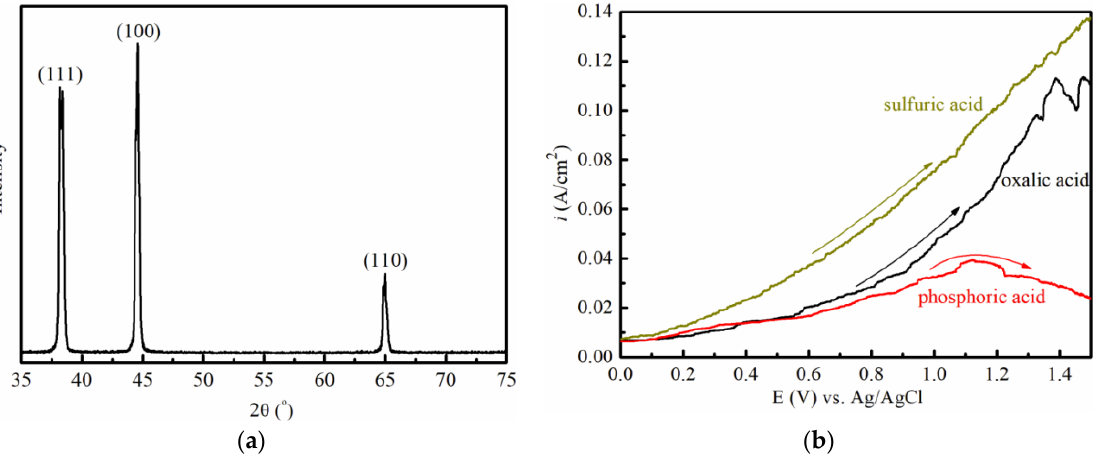
Figure 6. ( a ) The XRD peaks of aluminum foil. ( b ) The anodic polarization of aluminum in acid